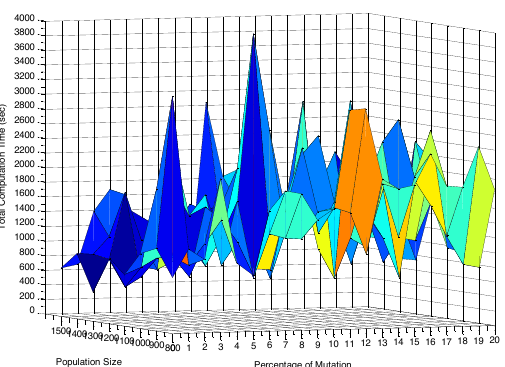
Figure 5.1.1 Generation Number when Total Percentage is 20%